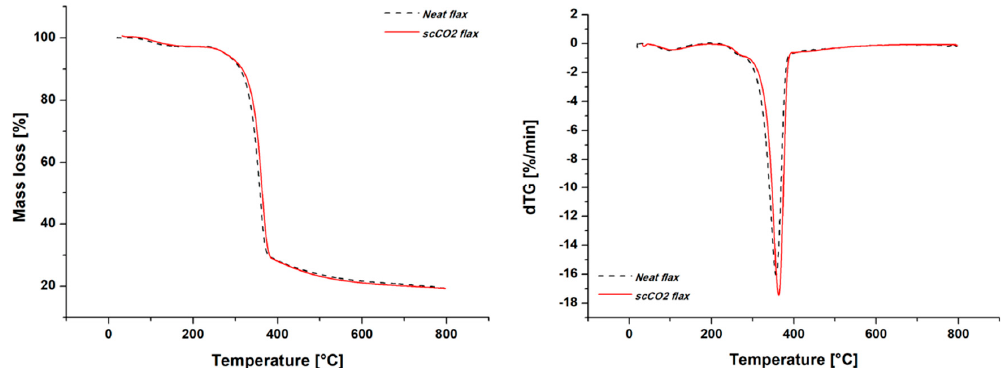
Figure 4. TGA thermograms and derivative thermogravimetry (dTG) curves of flax yarns before and after scCO 2 treatment.